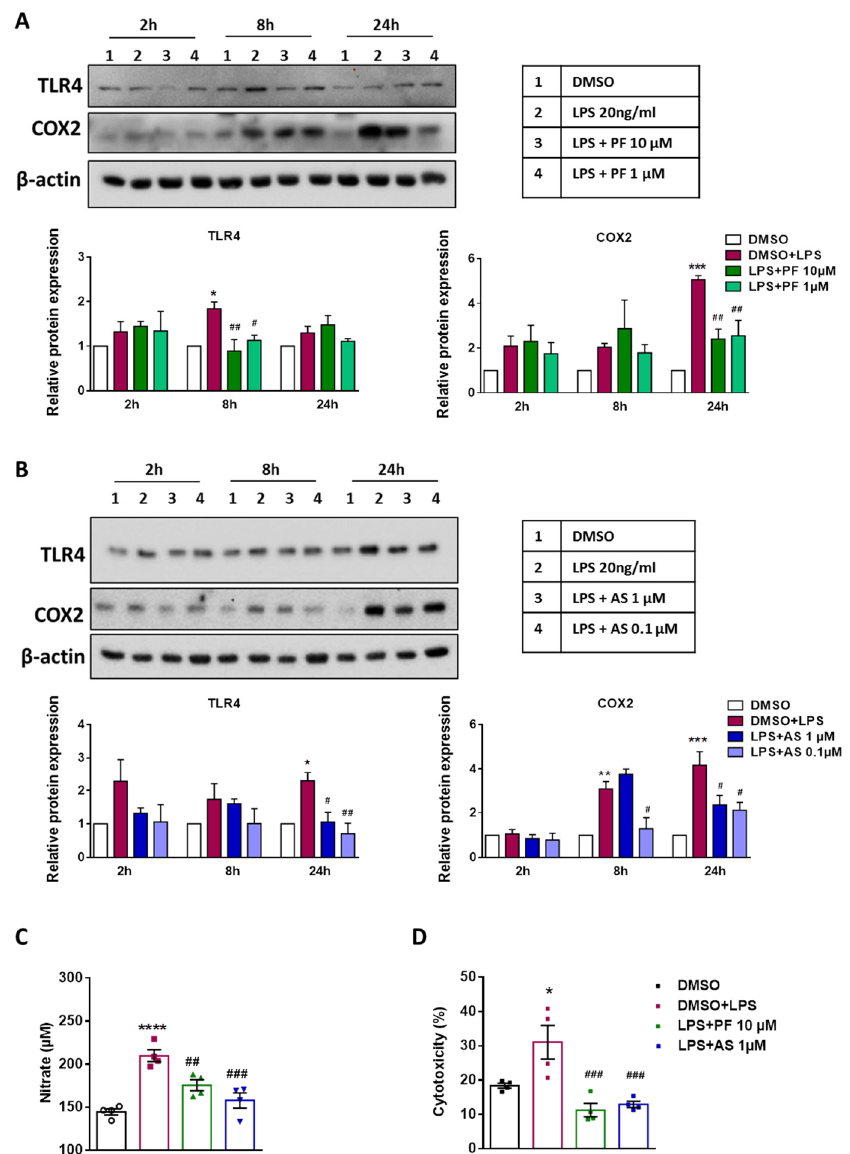
Figure 4. Inhibition of ATX and LPA5 down-regulates LPS-induced TLR4, COX-2 expression, nitric oxide production in BV-2 cells and reduces neurotoxicity of BV-2-conditioned medium. Cells were treated with DMSO (vehicle control), LPS (20 ng/mL) plus DMSO, ( A ) LPS plus PF8380 (‘PF’; 10 and 1 µM) or ( B ) LPS plus AS2717638 (‘AS’; 1 and 0.1 µM) for the indicated times. Cell lysates were collected and protein expression of TLR4 and COX2 was monitored by immunoblotting. β -actin was used as loading control. One representative blot for each protein is shown. Densitometric evaluation of immunoreactive bands is shown in the bar graphs. ( C ) Cells were treated with DMSO, LPS plus DMSO, and LPS plus PF8380 (‘PF’; 10 µM) or LPS plus AS2717638 (‘AS’; 1 µM) for 24 h. The production of NO was determined by measuring the total nitrate concentration in the supernatants. ( D ) CATH.a neurons were incubated for 24 h with conditioned media collected from LPS-treated (in the absence or presence of PF8380 (‘PF’; 10 µM) or AS2717638 (‘AS’; 1 µM)) BV-2 cells for 24 h. LDH levels were detected and neurotoxixity was calculated according to manufacturer’s protocol. Values are expressed as mean ± SEM of three independent experiments. (* p < 0.05, ** p < 0.01, *** p < 0.001, **** p < 0.0001 compared to DMSO control; # p < 0.05, ## p < 0.01, ### p < 0.001 compared to LPS-treated cells; one-way ANOVA with Bonferroni correction).